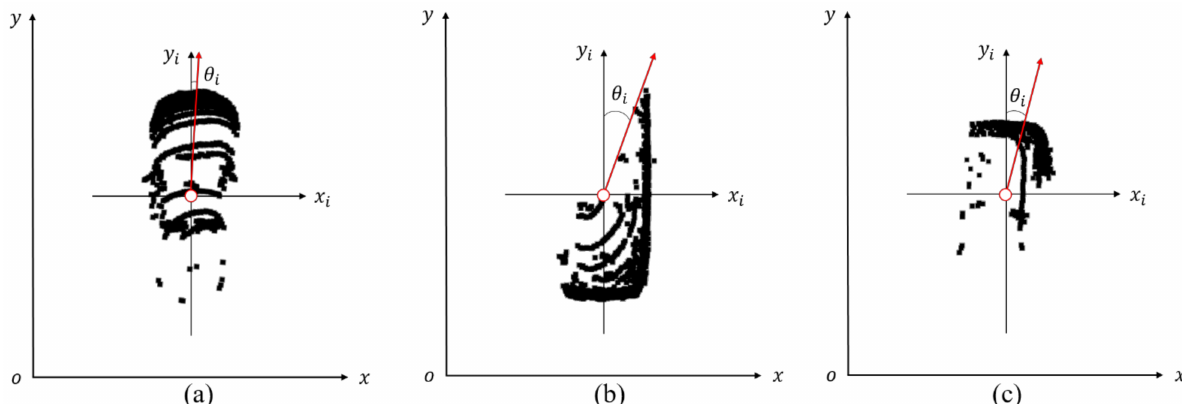
Figure 7. Schematic diagram of the PCA method for extracting the driving direction of the obstacle point cloud: ( a ) the direction obtained by the PCA is the driving direction; ( b ) the direction obtained by the PCA is the diagonal direction; ( c ) the direction obtained by the PCA is neither the driving direction nor the diagonal direction. The red arrow represents the direction obtained by